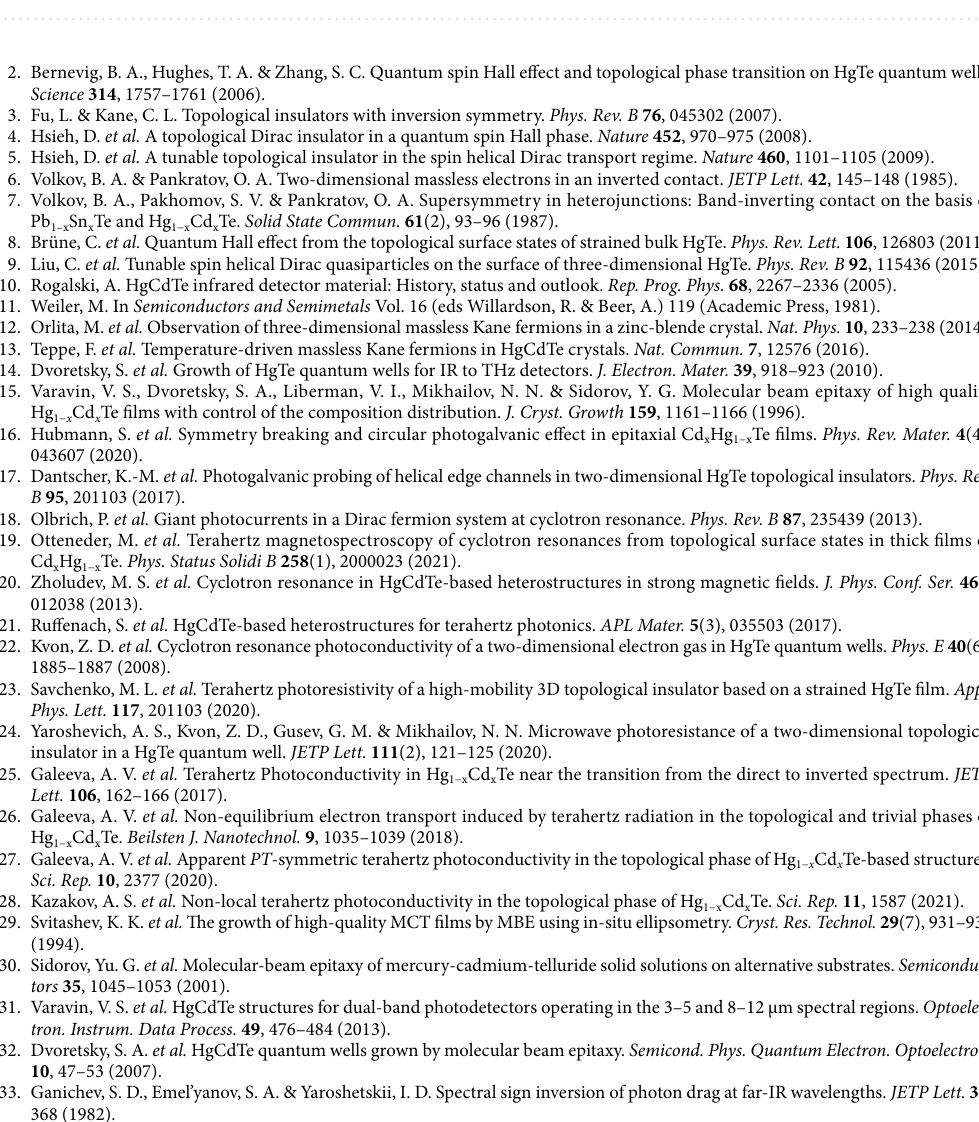
Figure 5. Resistivity temperature dependence of the samples under